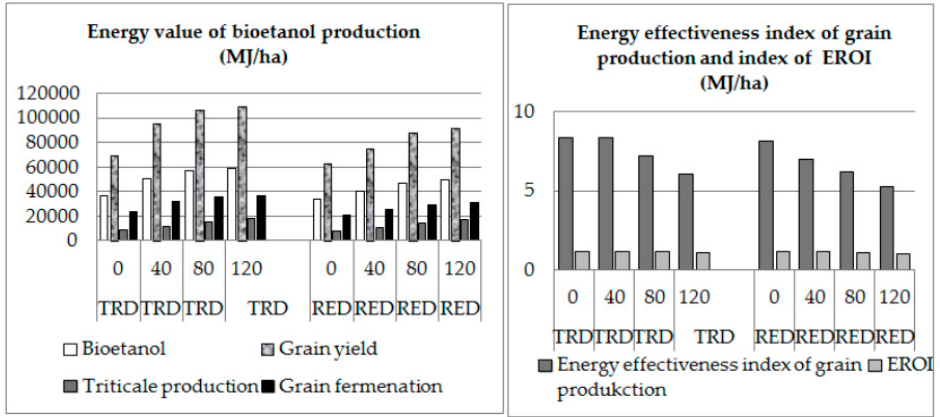
Figure 1. Energy value of bioethanol production and the energy effectiveness index (TRD—traditional tillage system; RED—reduced tillage system).